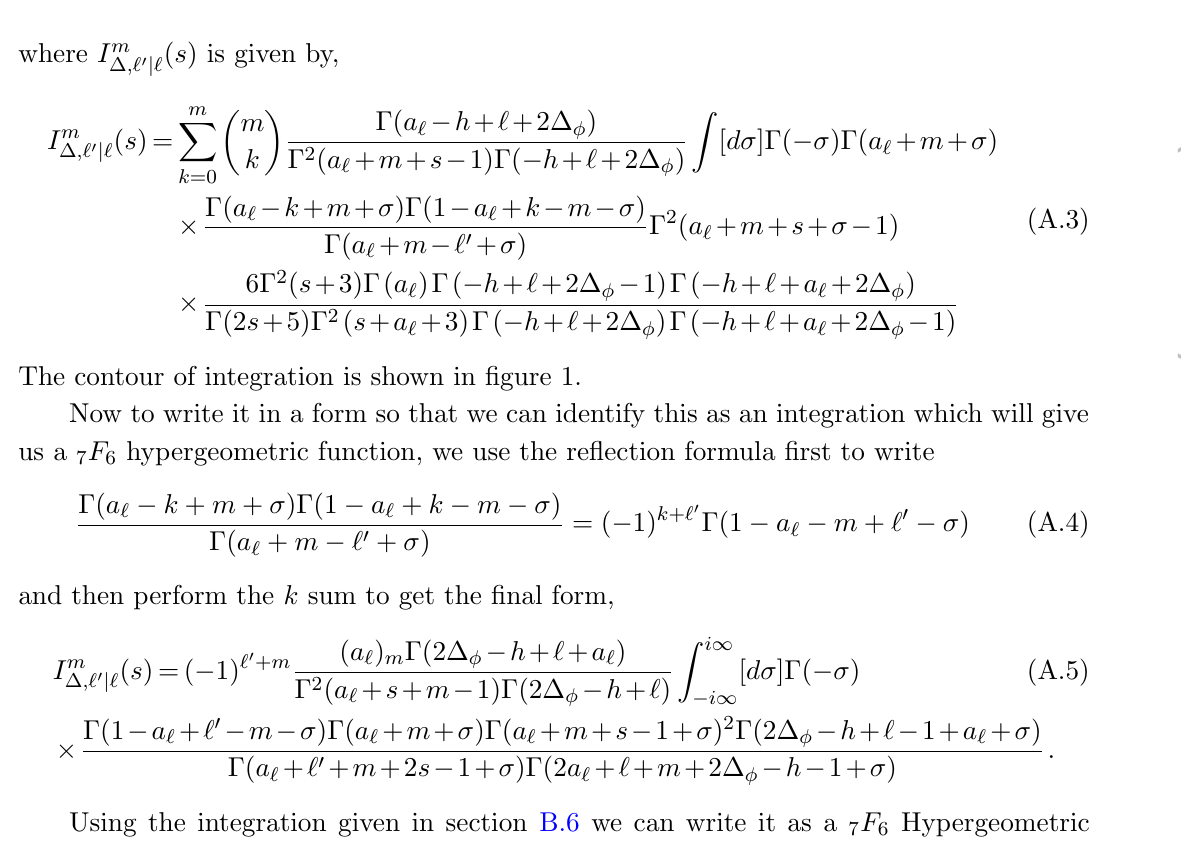
Figure 6. The contour gets pushed to left for ‘ > ‘ 0 such that it can pick up the poles coming from left. Therefore we subtract this o(cid:11) from our (cid:12)nal